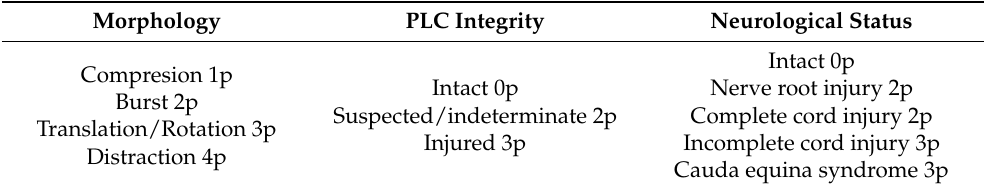
Table 1. Original TLICS score as published by Vaccaro et al. in 2005 [28].